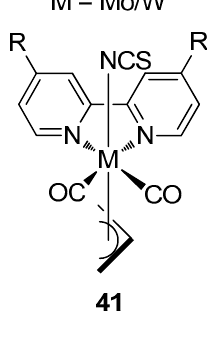
Figure 9. Some Mo/W ‐ based complexes active in CO 2